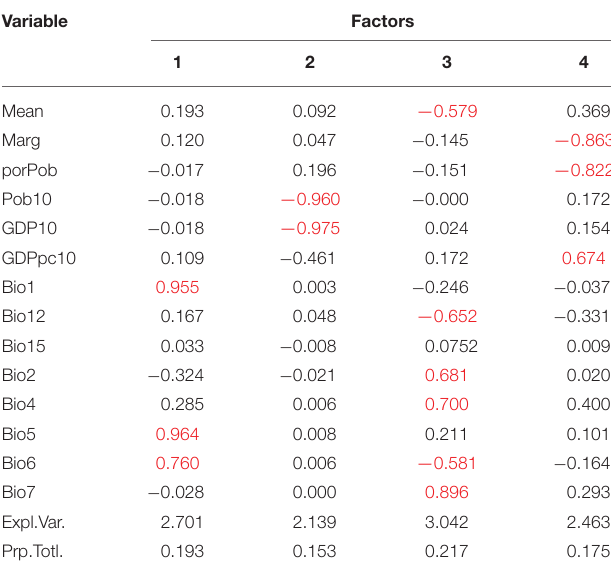
TABLE 3 | Factor loadings of the rotated principal components